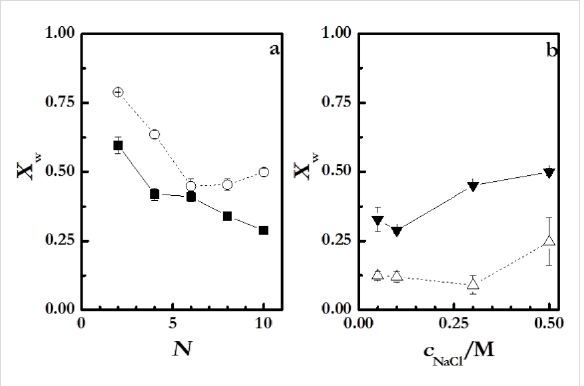
Figure 3: (a) Weight fraction of water as a function of N , obtained following the methodology proposed by Vöros [38], for (PDADMAC + PSS) N films formed at two different ionic strengths: 0.10 M (solid squares) and 0.50 M (open circles). (b) ) Weight fraction of water as a function of the ionic strength for (PDADMAC + PSS) N films: obtained through the methodology proposed by Vöros [38] (solid triangles) and through XPS (open triangles). The solid lines are to guide the